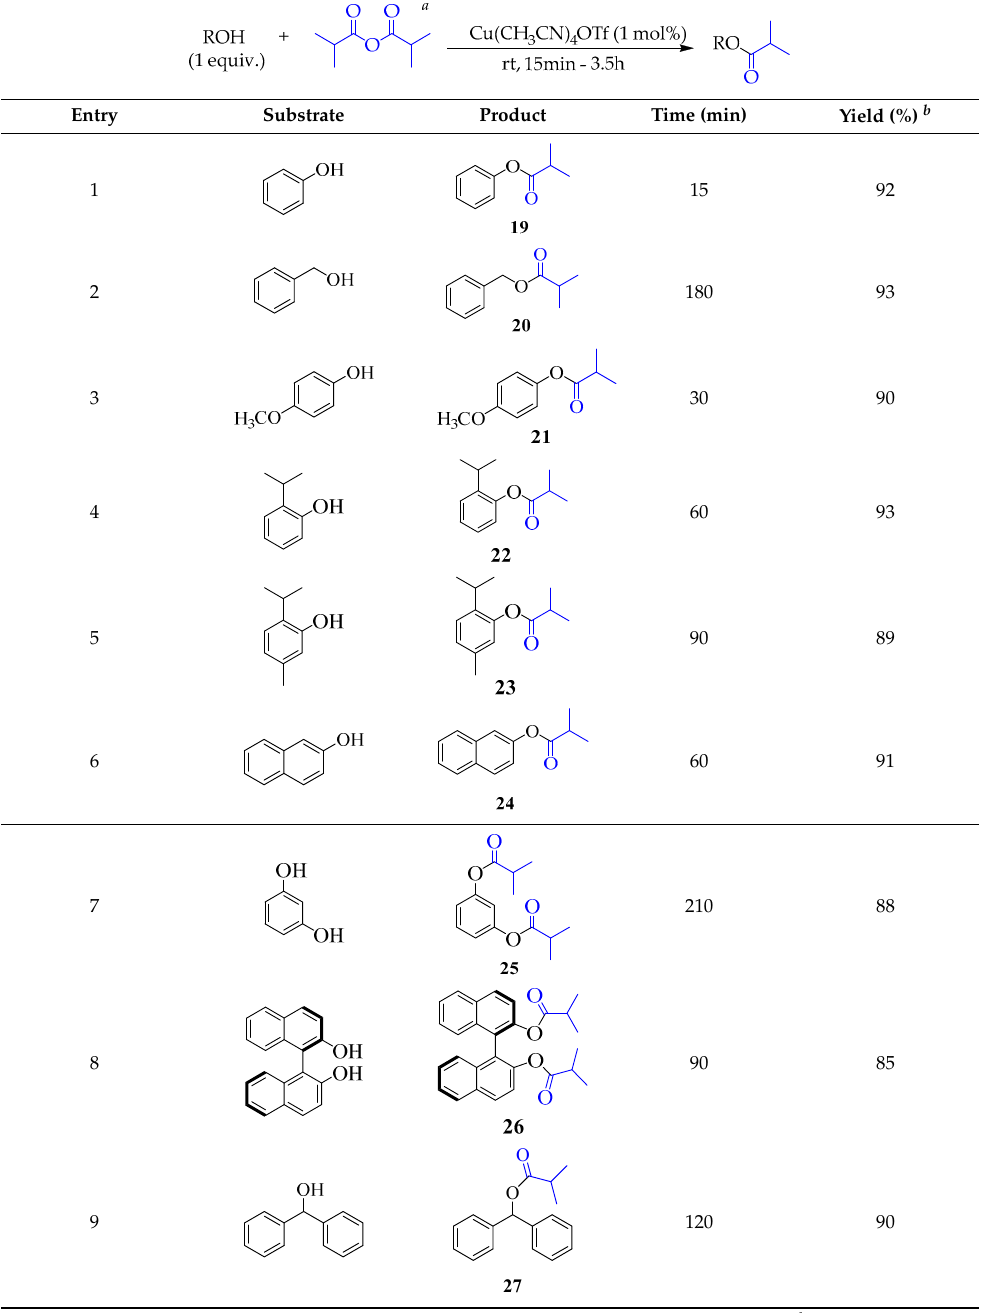
3 CN) 4 OTf. 3 CN) 4 OTf.